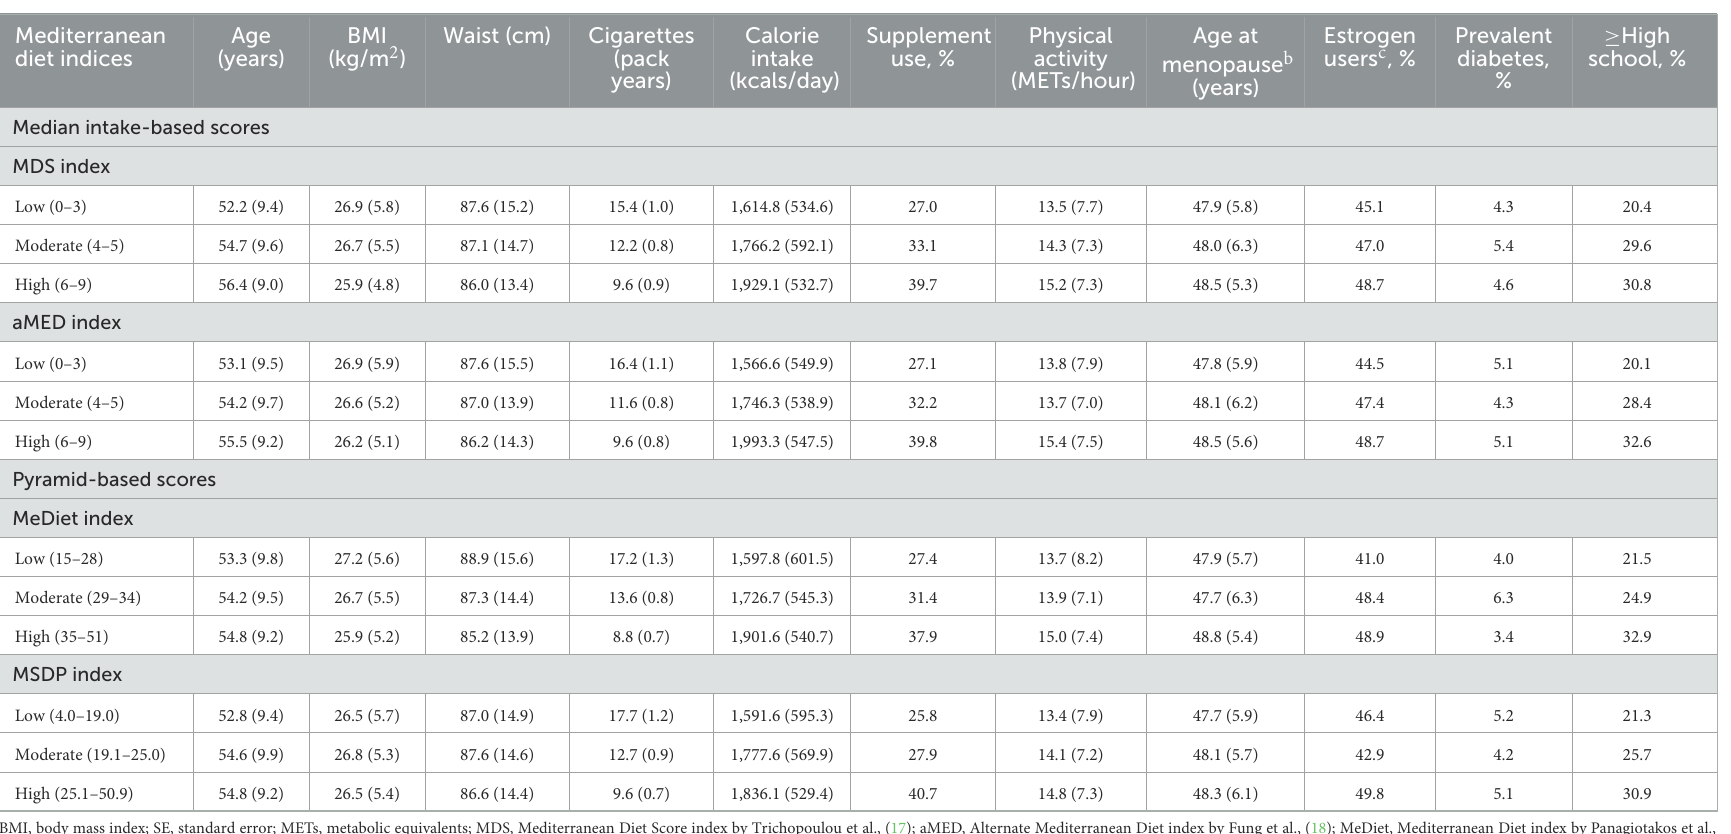
Age BMI Waist (cm) Cigarettes (years) (kg/m 2 )